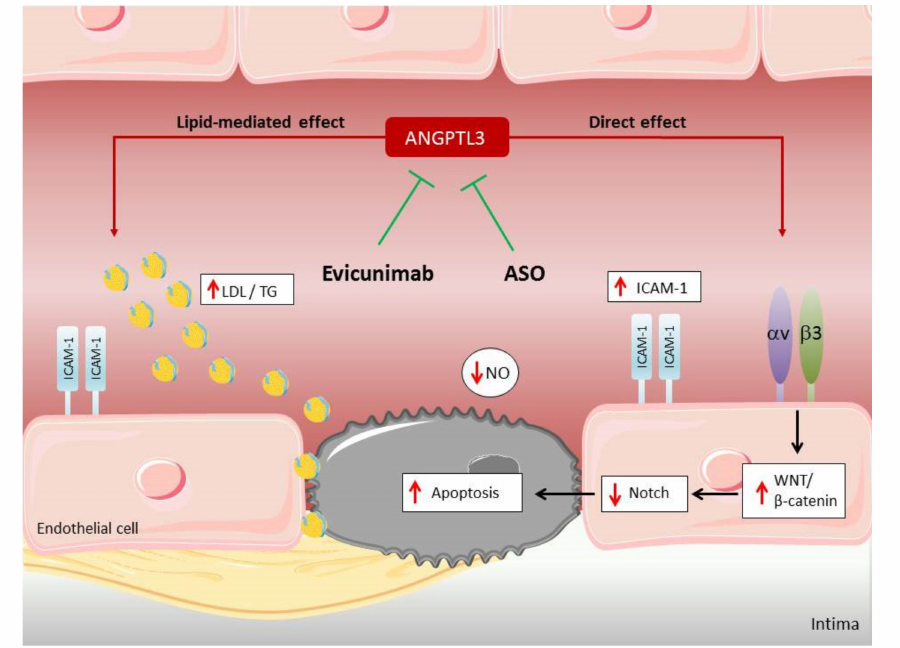
Figure 4. Lipid-mediated and possible direct effects of ANGPTL3 inhibitors on endothelial function. Endothelial dysfunction (ED) is characterized by increased apoptosis, expression of intercellular adhesion molecule (ICAM-1), and impairment of nitric oxide (NO) synthesis. ANGPTL3 inhibitors, such as the antibody Evinacumab and antisense oligonucleotide (ASO), reduce circulating low den- sity lipoproteins (LDL) and triglycerides (TG), hence contrasting lipid-mediated ED. In addition, ANGPTL3 inhibitors may directly protect from ED by impeding the binding of ANGPTL3 to en- dothelial integrin α v β 3, thus inhibiting the Wnt/ β -catenin signaling and restoring protective Notch signaling